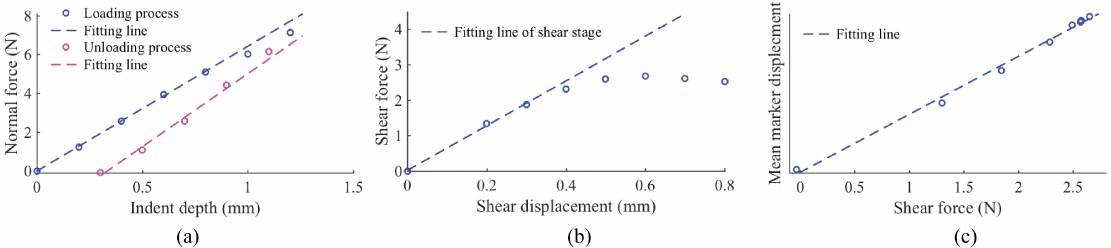
Figure 7. ( a ) when an indenter pressed on the GelSight surface in normal direction, the force is in linear relationship with the indenting depth, but the unloading curve is different from the loading curve due to the viscoelasticity; ( b ) when an indenter moves on GelSight in the shear direction, the shear force is initially proportional to the shear displacement of the indenter, but then grows slowly and comes to a constant value when partial slip or slip occur; ( c ) under the shear force, the average marker displacement is proportional to overall shear force, regardless of whether it is in the shear stage or slip